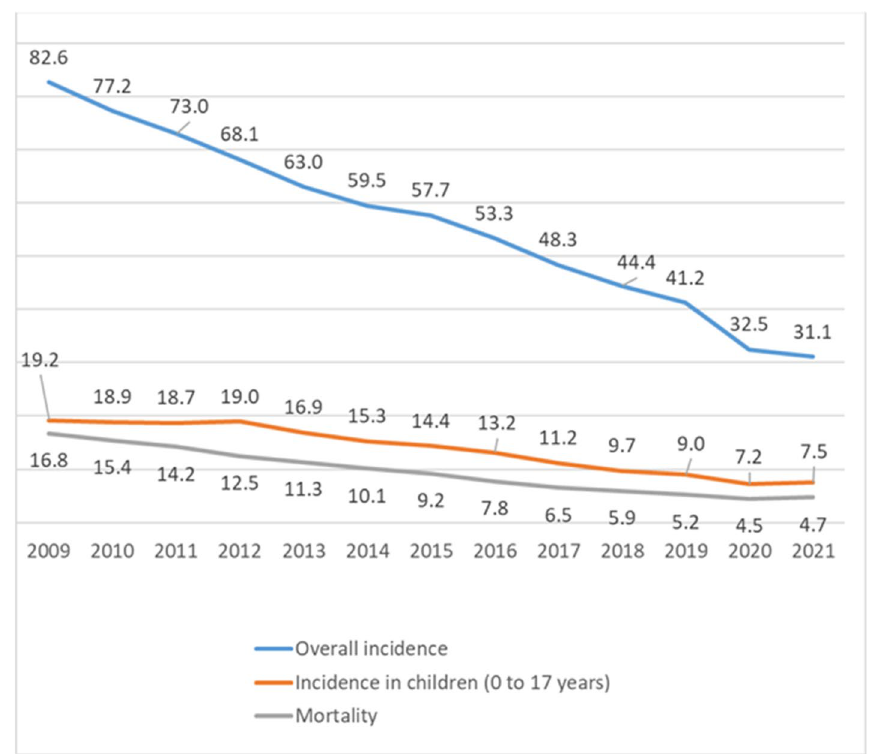
Fig. 10 Dynamics of the